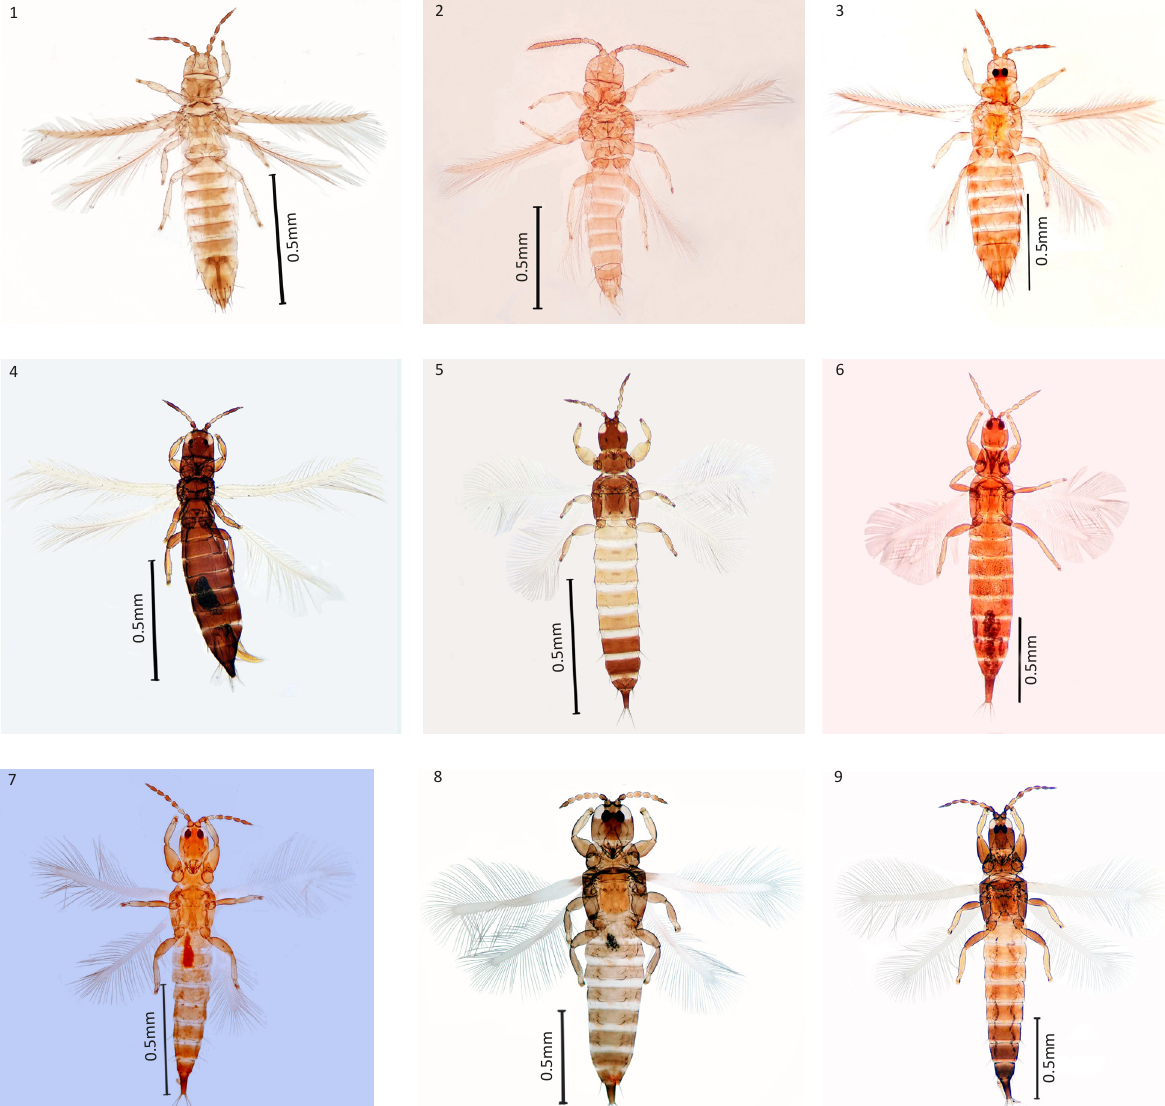
III anterolateral to ocellar triangle. Head about as long as wide, projecting weakly in front of eyes. Metascutal campaniform sensilla present. Abdominal tergite laterally with small dentate microtrichia on posterior margin; tergite VIII with long slender